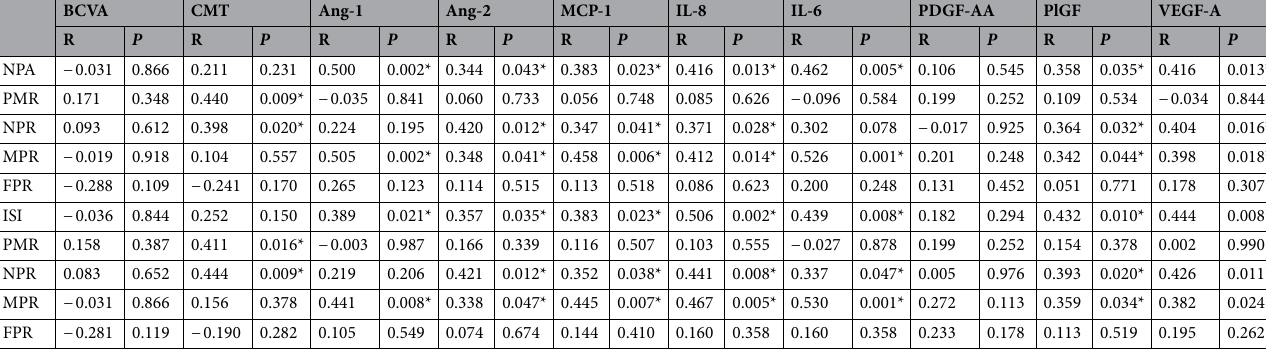
Table 4. Correlation of partial ischemia in different retinal zones with visual acuity, central macular thickness, and levels of cytokines. BCVA: best-corrected visual acuity, CMT: central macular thickness, FPR: far- peripheral region; ISI: ischemic index, MPR: mid-peripheral region, NPA: non-perfusion area, NPR: near- peripheral region, PMR: peri-macular region, R: Spearman’s correlation coefficient. P -values were calculated using Spearman’s correlation. * P -value < 0.05.